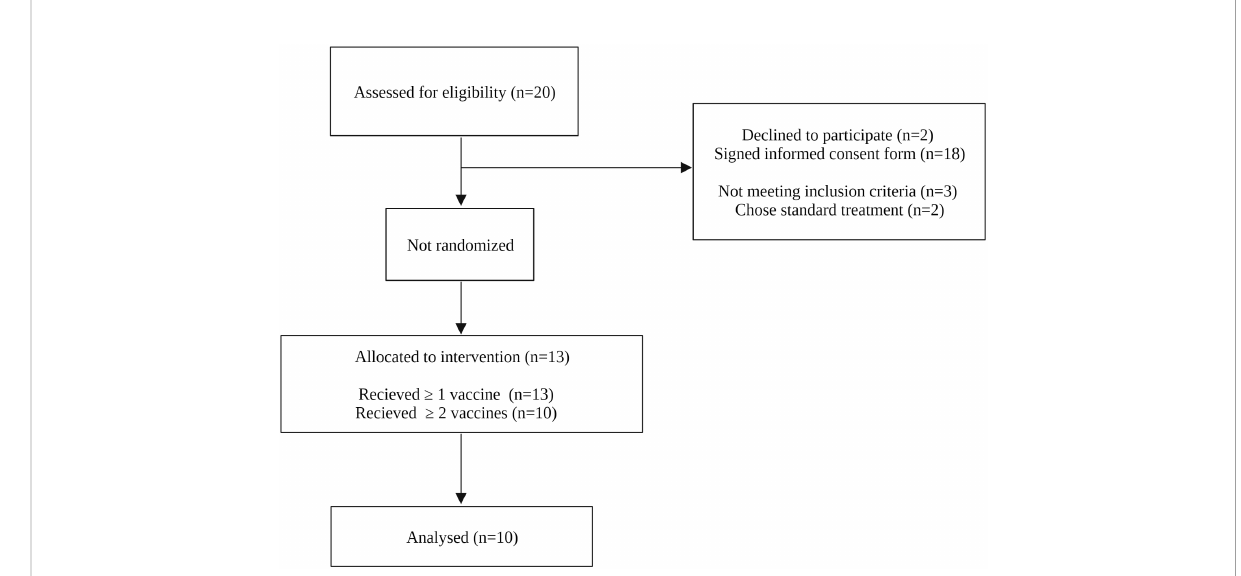
FIGURE 1 Consort diagram. Twenty patients with metastatic solid tumors were assessed for eligibility. Thirteen patients were enrolled and received the study treatment. Three patients received < 2 vaccines and were replaced with new participants. Ten patients received ≥ 2 vaccines and were evaluated.